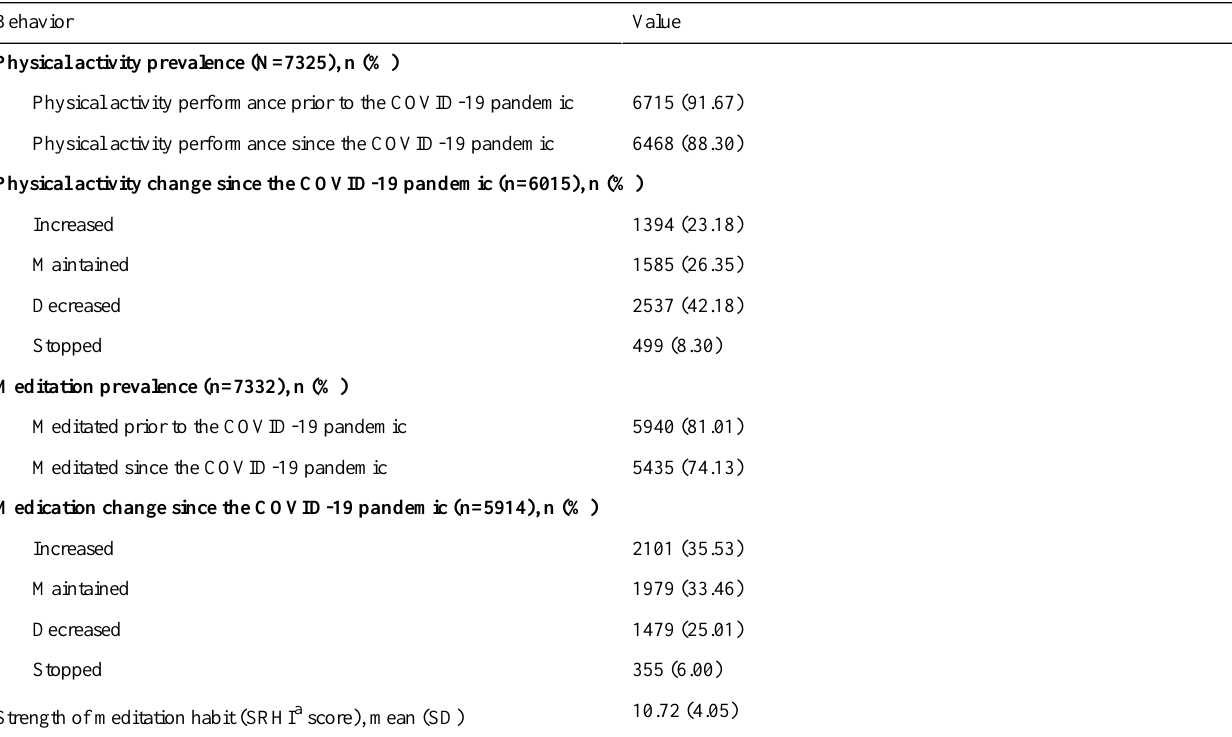
Table 2. Self-reported engagement in preventative health behaviors